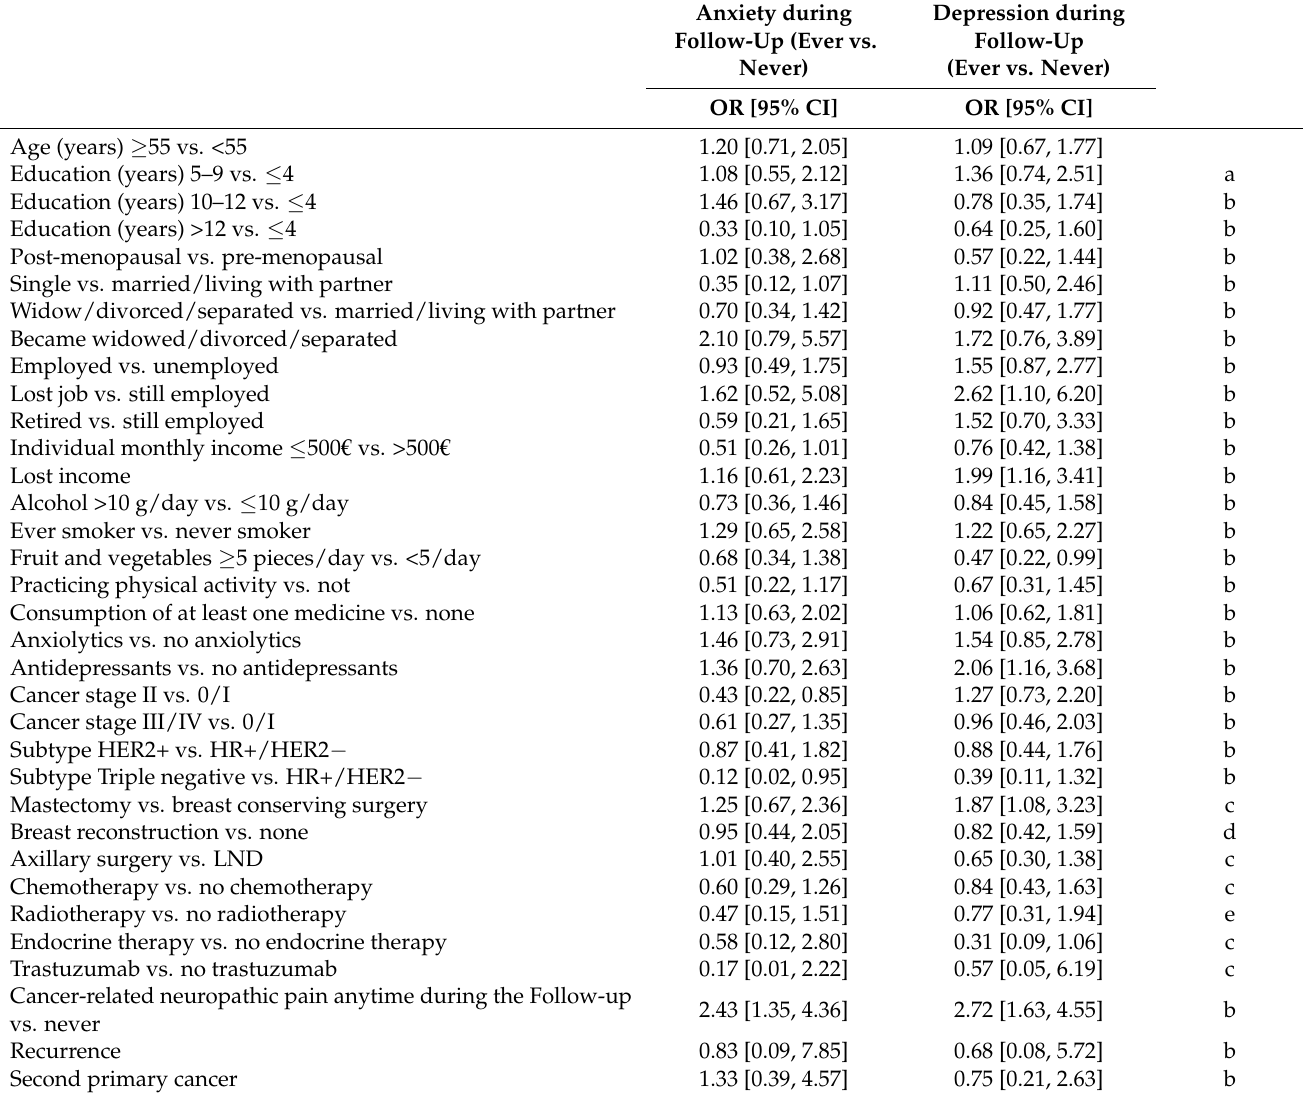
Table 4. Association of baseline factors, changes in socio-demographic and clinical characteristics, and treatments with having clinically significant anxiety/depression symptoms (anxiety/depression sub score of the Hospital Anxiety and Depression Scale [HADS-A/HADS-D] equal or higher than 11) at any evaluation during the five-year follow-up, among participants with HADS-A/HADS-D < 11 at baseline (incident cases). Anxiety during Follow-Up (Ever